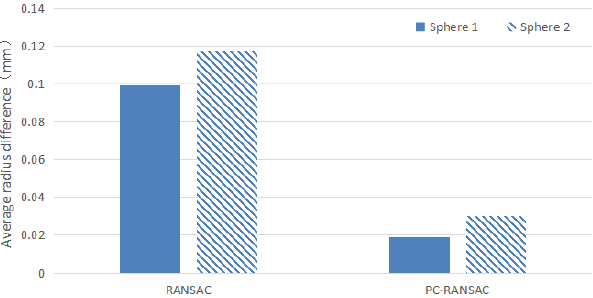
Table 3. Average sphere center distance detected by each algorithm.